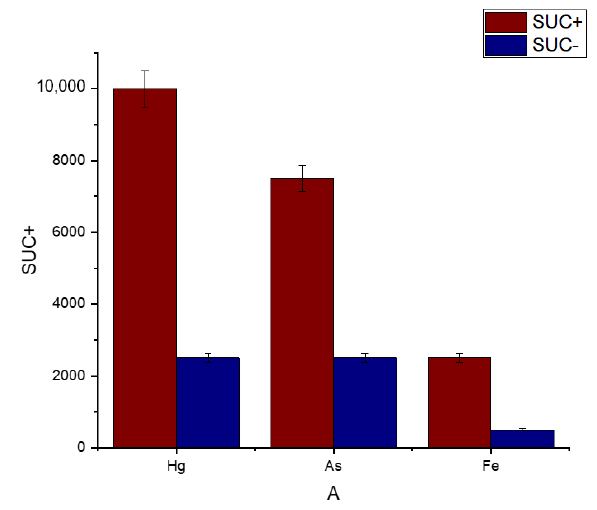
Figure 3. High metal resistance of EPS producing CUI-P1 Acinetobacter sp.